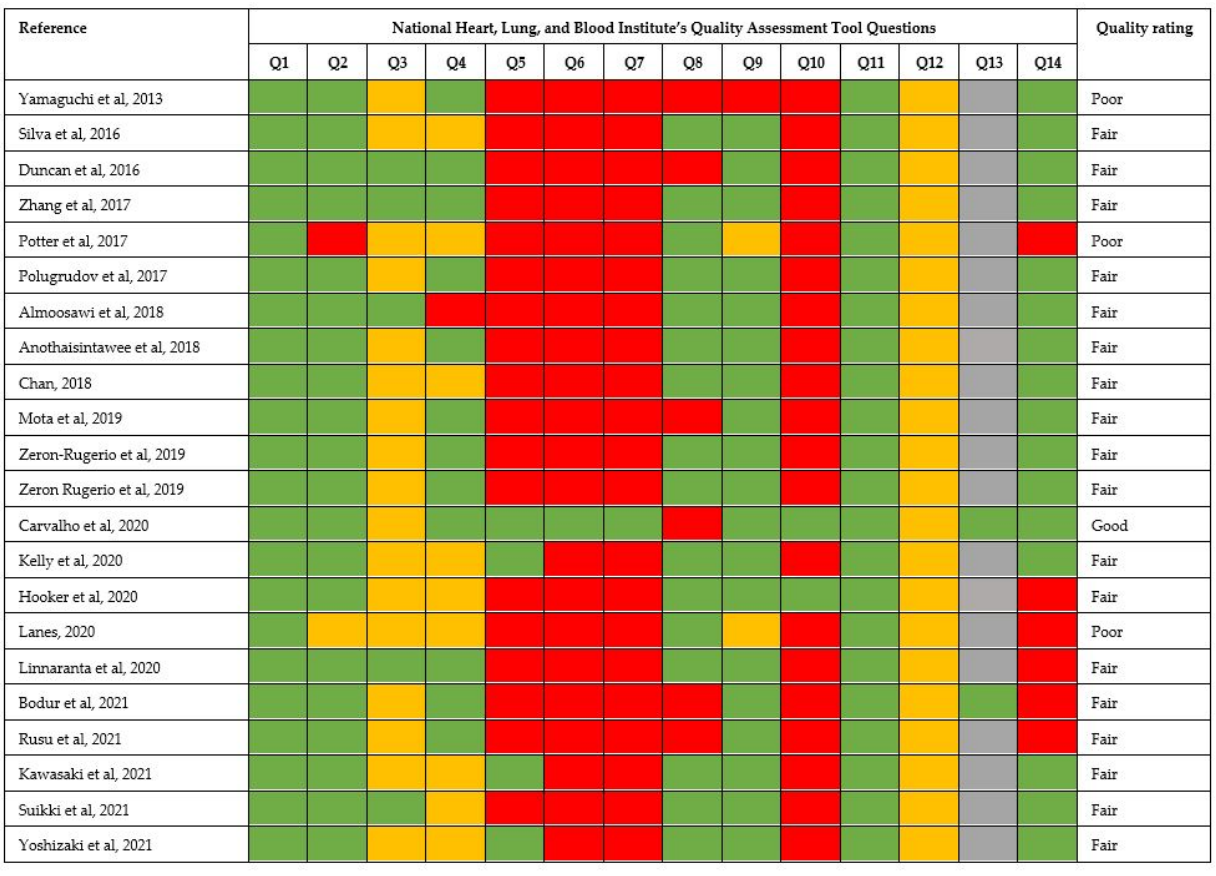
Figure 2. Quality assessment [17–38].